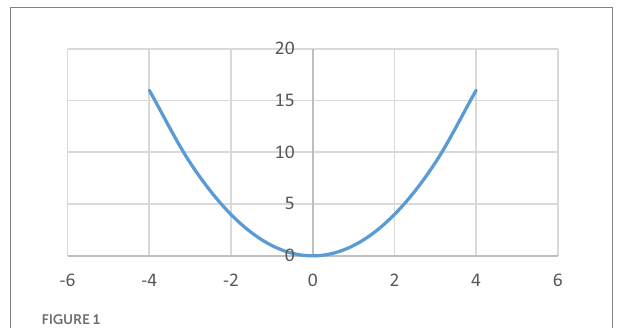
FIGURE 1 Visual representation of the function f(x) = x 2 in the Cartesian coordinate